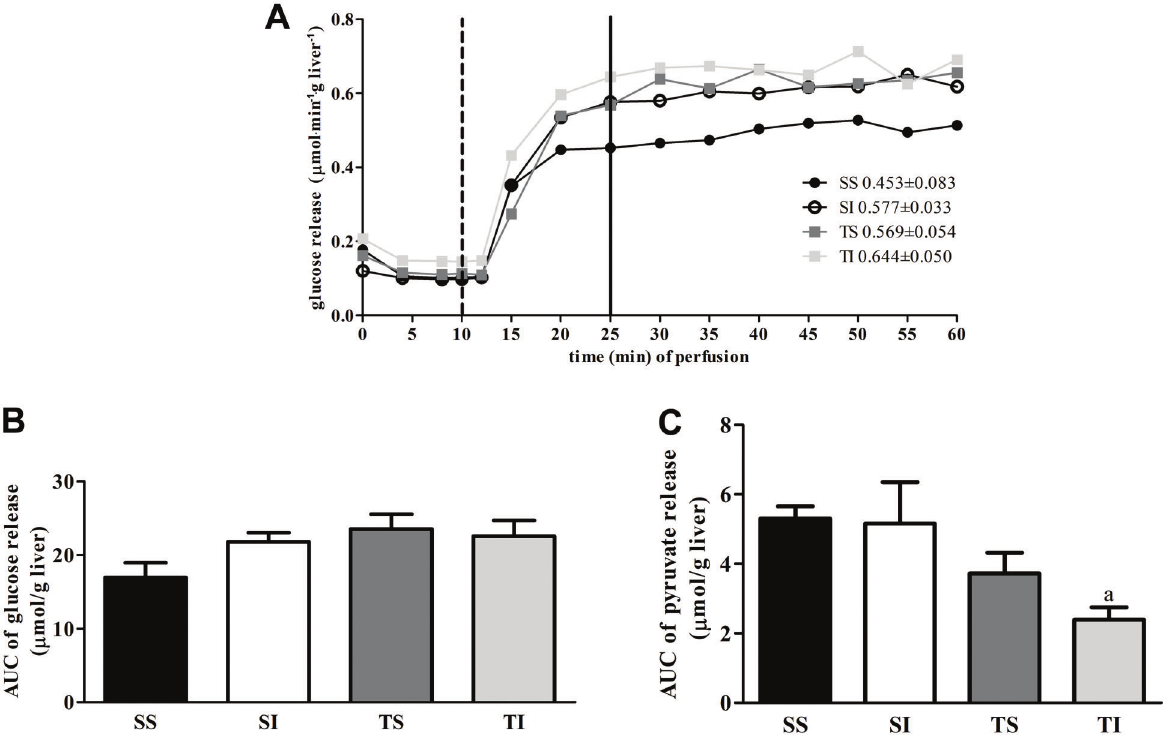
Figure 4. Kinetics and steady-state ( A , numerical values) of liver glucose release and area under curve (AUC) of glucose ( B ) and pyruvate ( C ) release during perfusion with lactate + glycerol of Swiss mice of groups SS: sedentary treated with saline; SI: sedentary treated with insulin; TS: trained treated with saline; and TI: trained treated with insulin. Data are reported as means ± SE for n=5 – 7/ group. a P o 0.05 vs SS